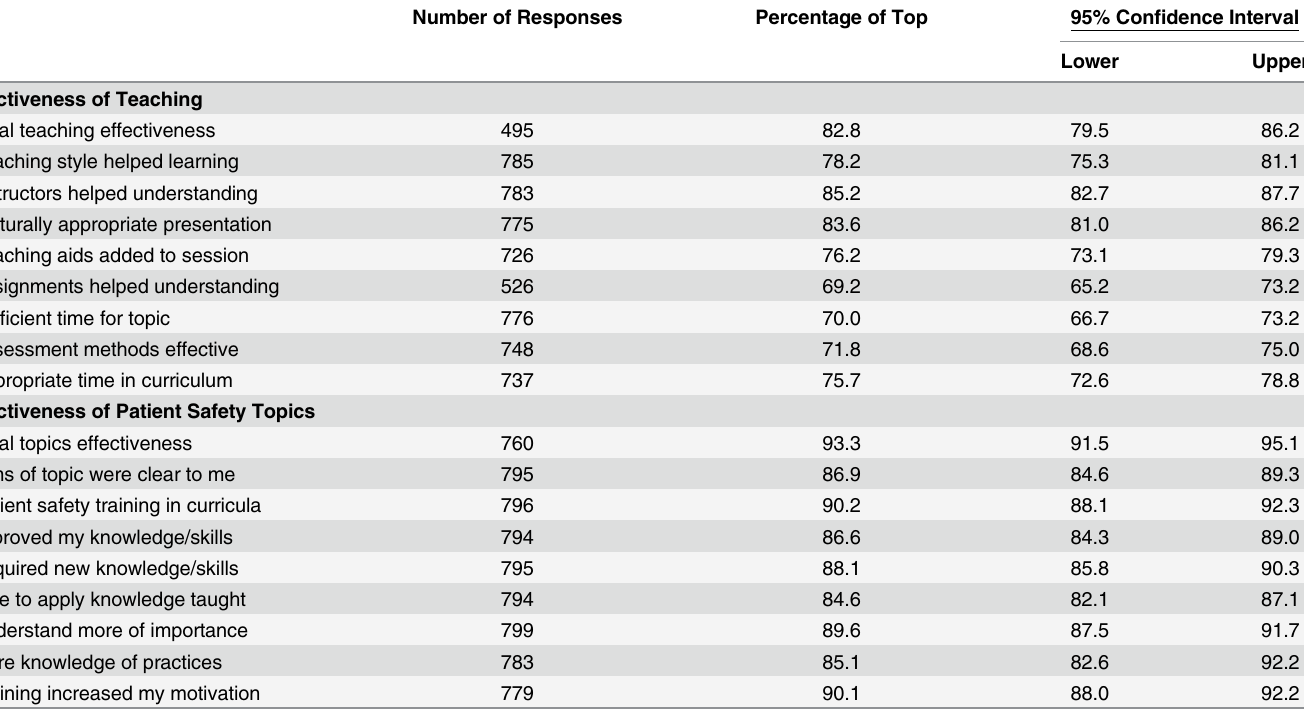
Table 2. Percentage of top responses on student perceptions about teaching effectiveness and patient safety topics taught, post-teaching survey.